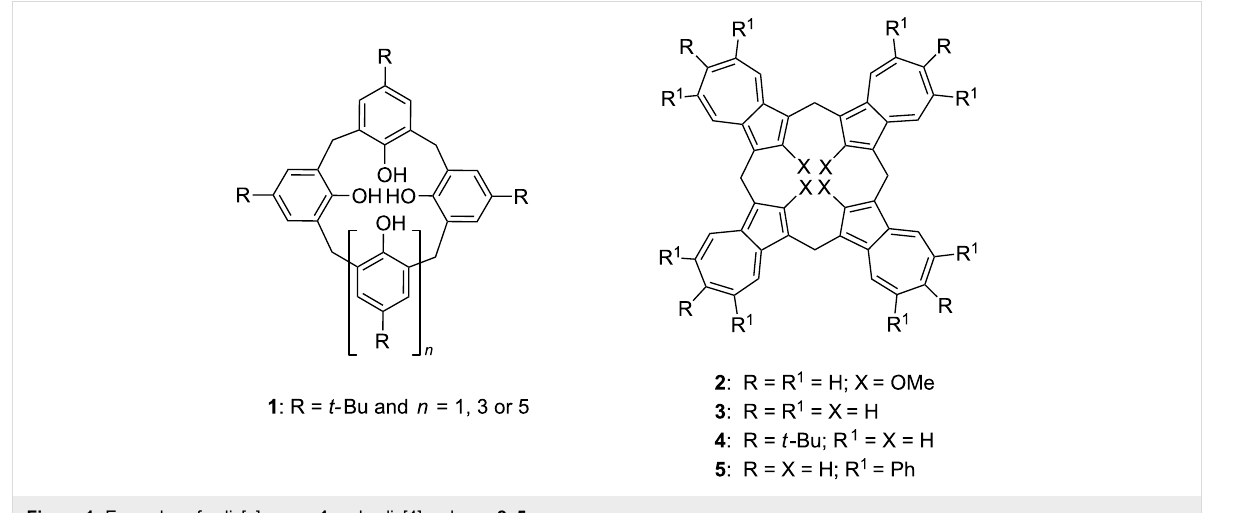
Figure 1: Examples of calix[ n ]arenes 1 and calix[4]azulenes 2 – 5